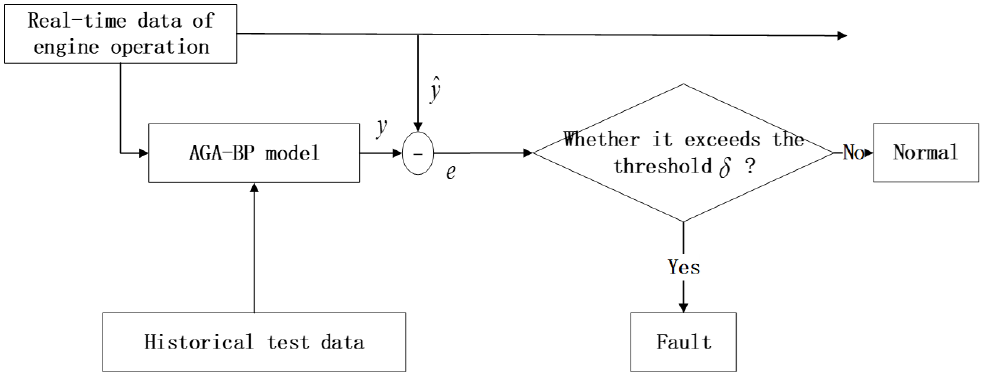
Figure 1. Principle of the fault detection method for the A G A-BP model.